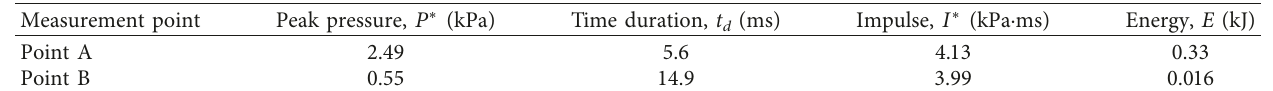
Table 3: Comparison of blast parameters at point A and point